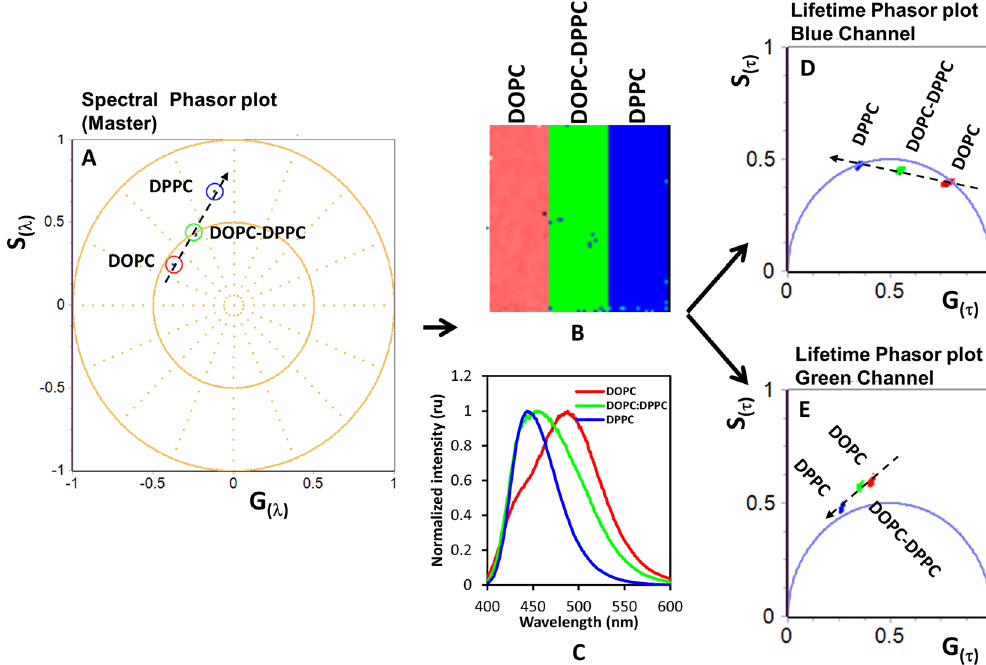
Figure 1. Schematic representation of the Multi-D phasor approach. Spectral and lifetime information were acquired in 3 samples in cuvettes. ( A ) After phasor transformation, the graph represents the spectral phasor. ( B ) The square in the center of the figure represents 3 pixels with different phospholipid composition. ( C ) Fluorescence spectra of LAURDAN in the 3 phospholipid mixtures used for this figure. ( D , E ) Graphs represent the phasors at two emission wavelengths. Selecting the spectral phasor plot as the master plot it is possible to identify in the common image (the 3 pixels at the center of the figure) the region selected by the 3 colored cursors in the master phasor plot. These pixels are highlighted using the same color code also in the lifetime phasor plots ( D , E ). A linear combination indicated by the dotted black lines in the master phasor plots gives linear combinations in the secondary lifetime phasor